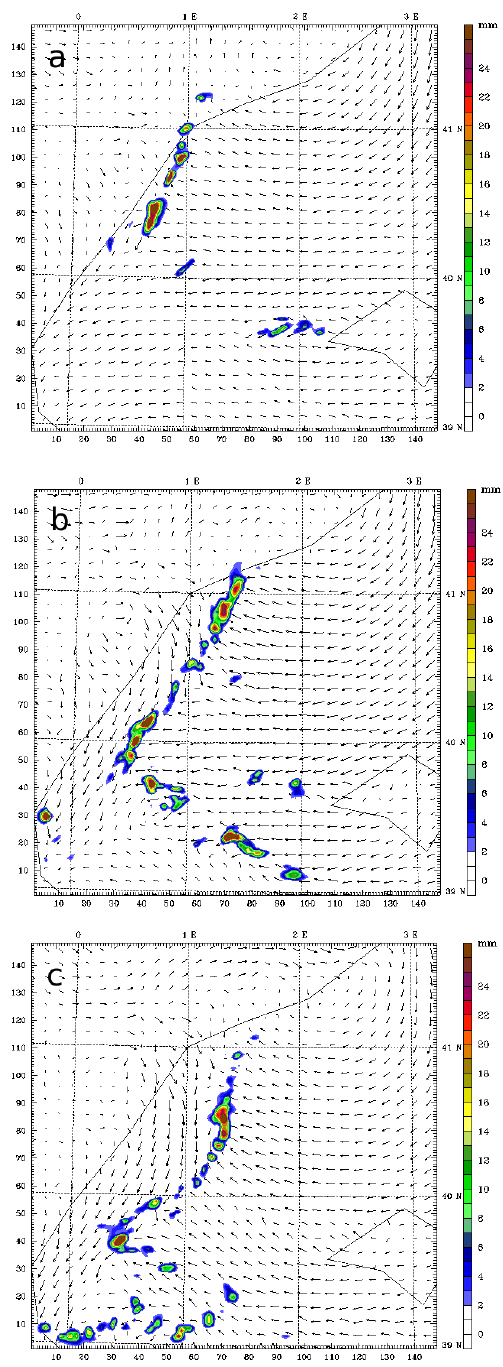
Figure 6. 1h accumulated precipitation (color-filled contours) and surface wind field (vectors) at (a) 22:00UTC (maximum wind vec- tor 11.1ms − 1 ) on 5 September 2011, (b) 03:00UTC (maximum wind vector 9.8ms − 1 ) and (c) 06:00UTC (maximum wind vector 9ms − 1 ) on 6 September 2011 for the IP